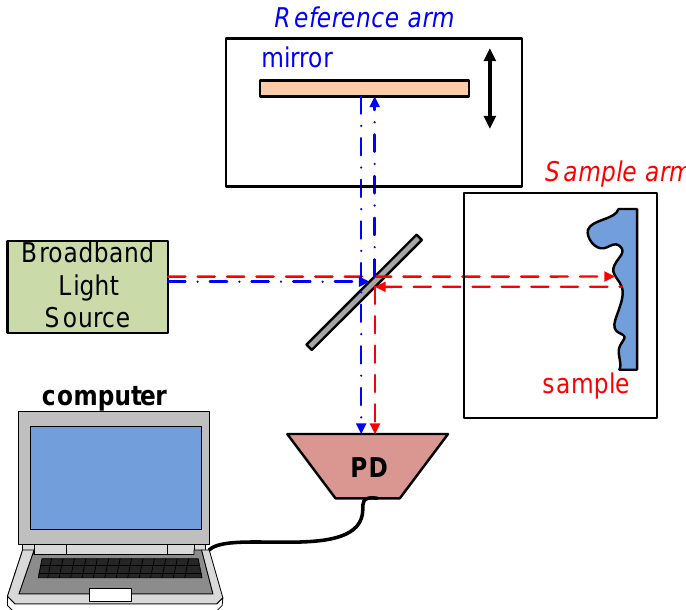
Figure 1. System setup of TD-OCT (PD: